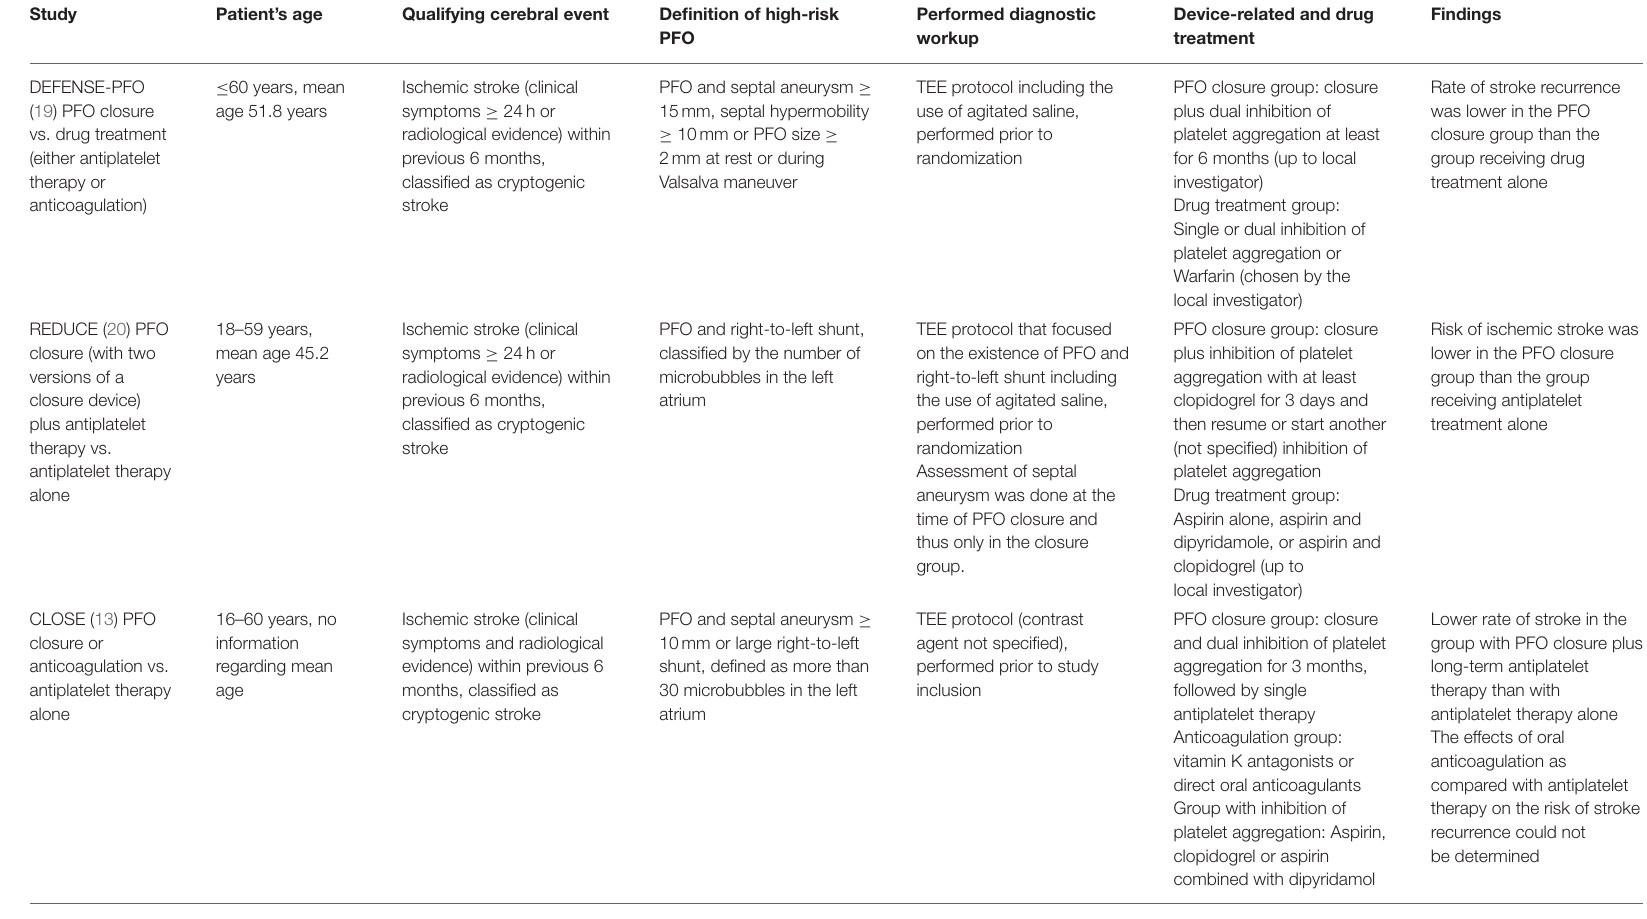
TABLE 1 | Comparisons of PFO closure vs. drug treatment alone in patients with stroke and